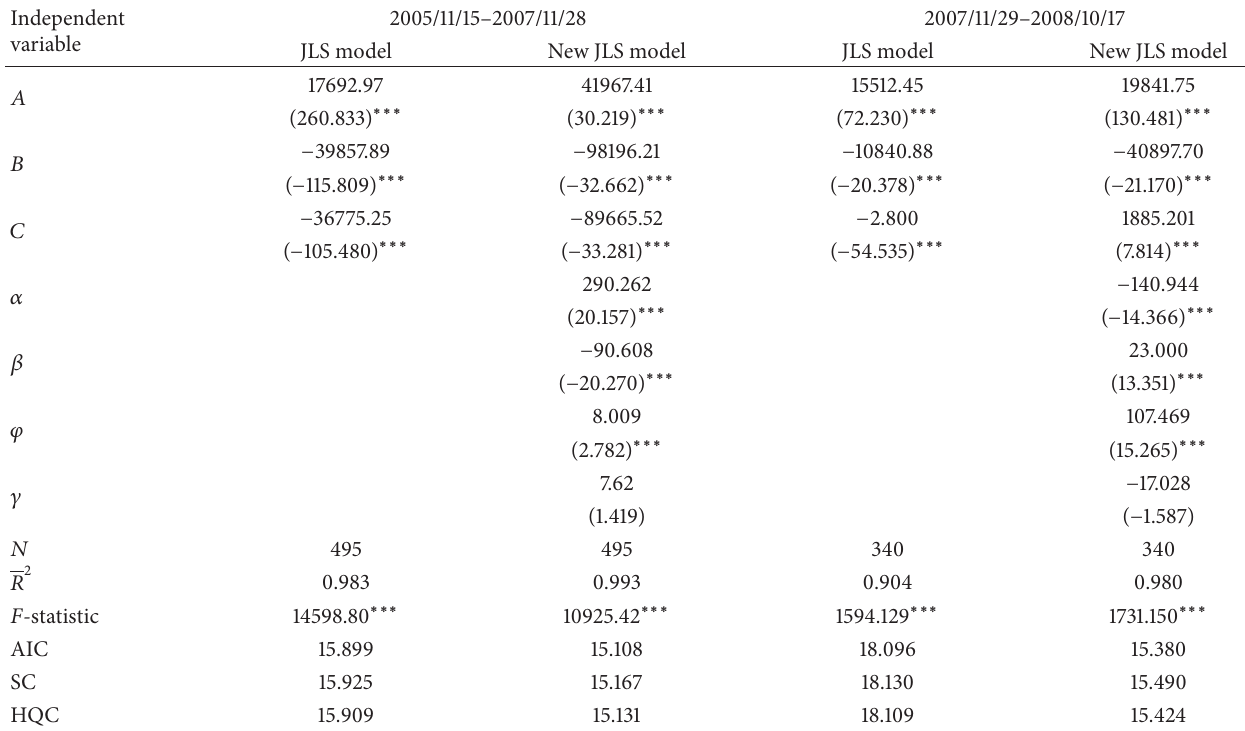
Table 7: The significance test results of the new and the original JLS model for the 2005–2008 SZSC